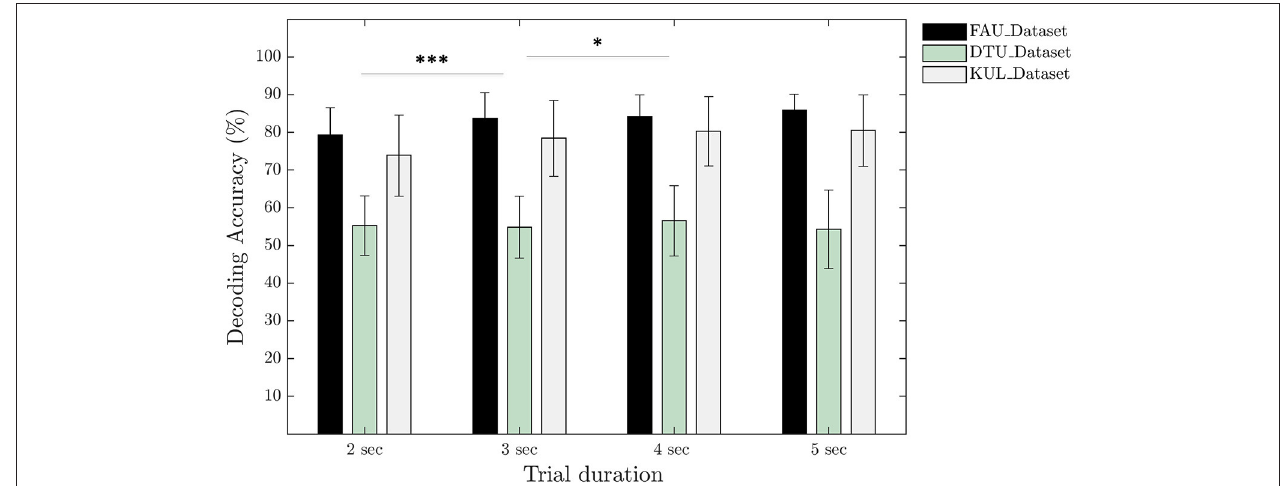
FIGURE 4 | Comparison of the decoding accuracies calculated for different trial durations per dataset. Statistical analysis based on paired Wilcoxon signed-rank test and pooled over all subjects together from the three datasets ( ∗ p < 0.05; ∗∗∗ p < 0.001).